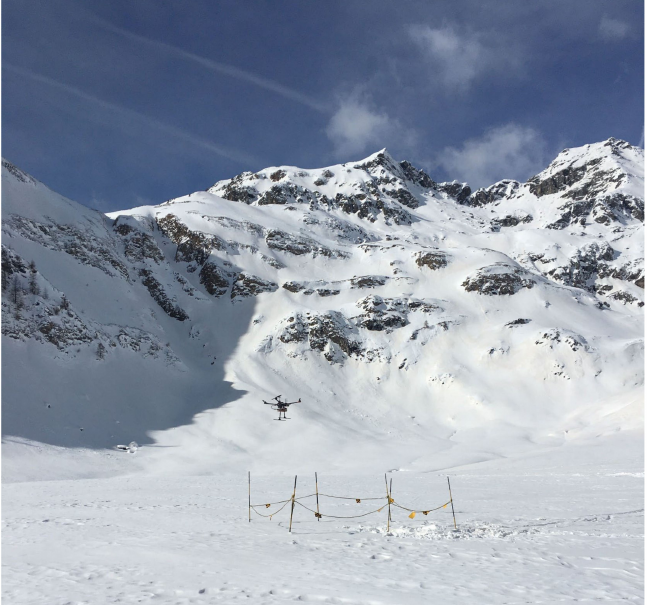
Figure 4. Gressoney test site. The monitored area with snow thickness and density measurements is delimited by rods and